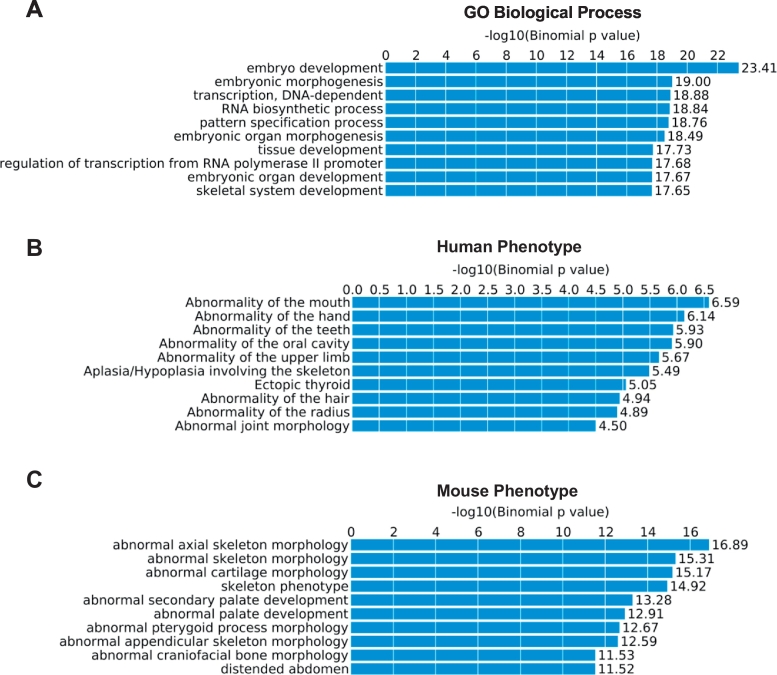
Top 10 results from functional annotation and GO enrichment analysis of osteoblast-specific hypermethylated DMRs by using the GREAT package (McLean et al., 2010).